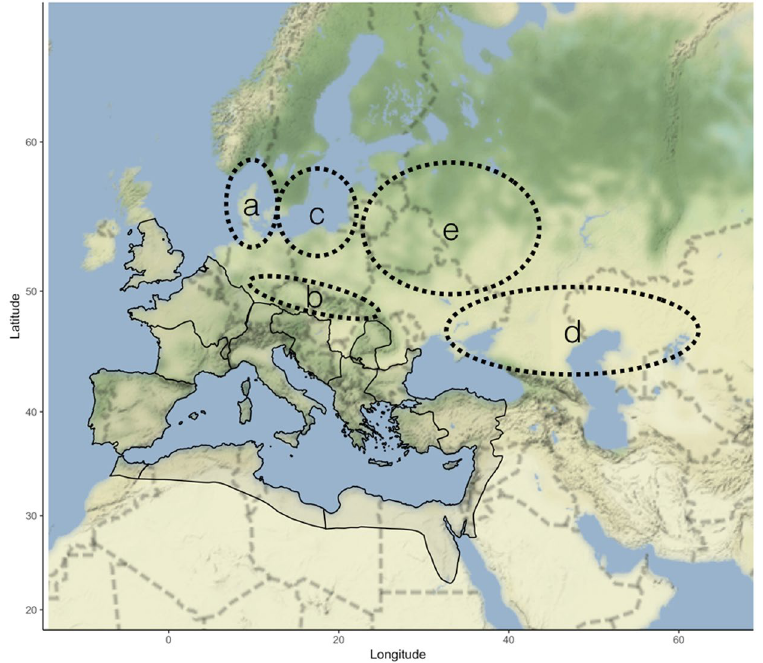
Figure 1. Roman Empire at its territorial height in 117 A.D. Locations are highlighted for ( a ) the Cimbri and Teutones before 117 B.C., ( b ) the Marcomanni and Quadi before 160 A.D., ( c ) hypothesized location for tribes which would eventually become the Goths before 370 A.D., ( d ) possible migration path of the Huns around 400 A.D., and ( e ) Slavic-speaking groups prior to the Migration Period (500 A.D.). There is low certainty in the placement of linguistic groups prior to the Migration Period. While linguistic territories were broad, populations were likely concentrated in smaller areas. Map generated in R (3.3.2) 40 using map tiles by Stamen Design (under CC BY 3.0. Data by OpenStreetMap, under ODbL).